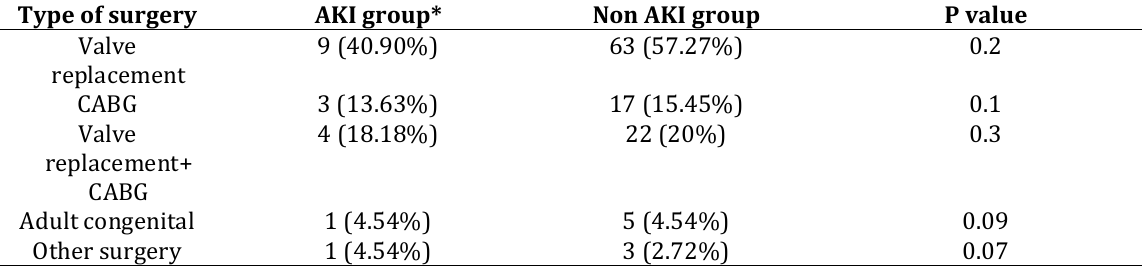
Table- 2 Different type of surgery in AKI and non AKI group Type of